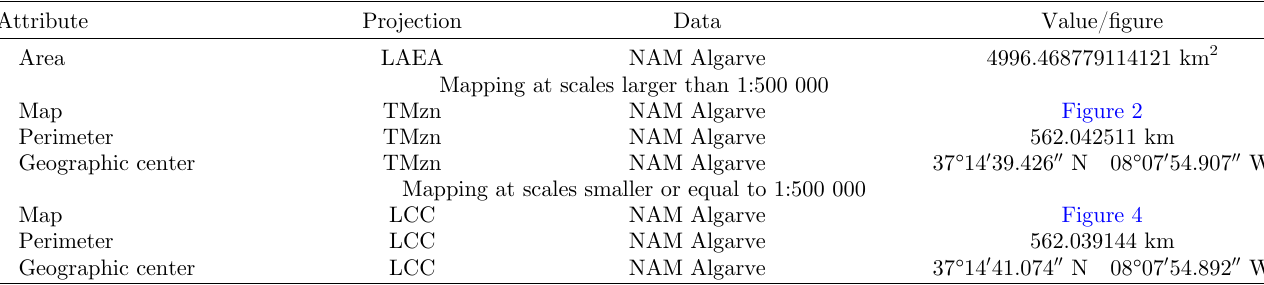
Table 11. Variations by changing the origin of PT-TM06 to the geographic center of the Algarve. Table 12. Map, area, perimeter and centroid of the Algarve.